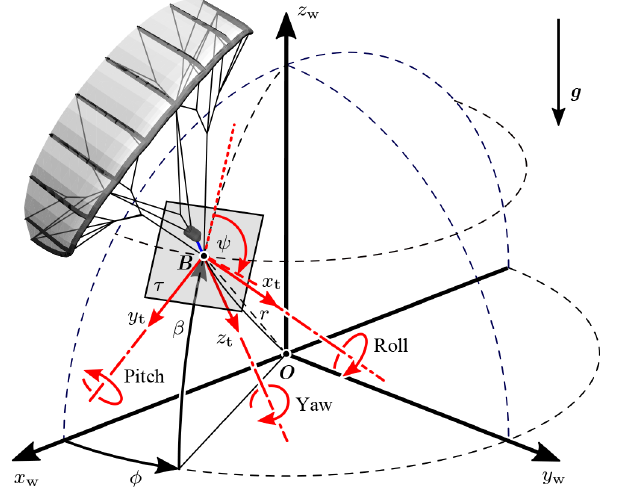
Figure 6. Ground reference frame ( x w ,y w ,z w ), tether refer- ence frame ( x t ,y t ,z t ), heading angle ψ and spherical coordinates ( β,φ,r ). Only in the case of a straight tether does the z t axis point in the radial direction to the ground attachment point O